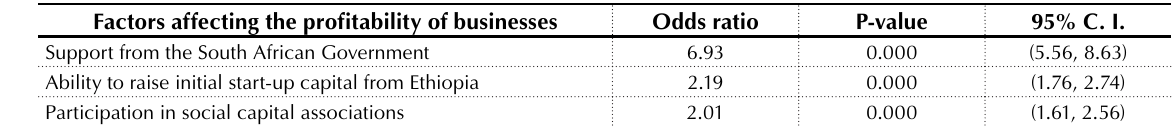
Table 7. Results from binary logistic regression analysis ( n = 3,045) Factors affecting the profitability of